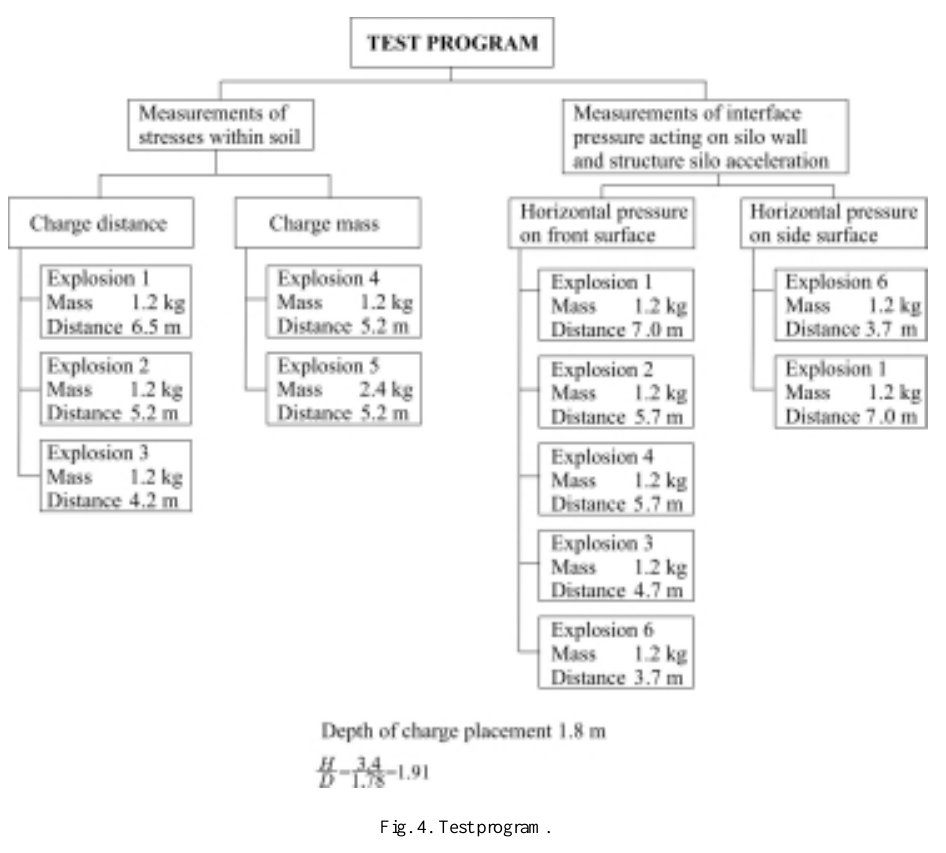
Fig. 3. Configuration scheme of buried RC cylindrical silo with a PVC pipes